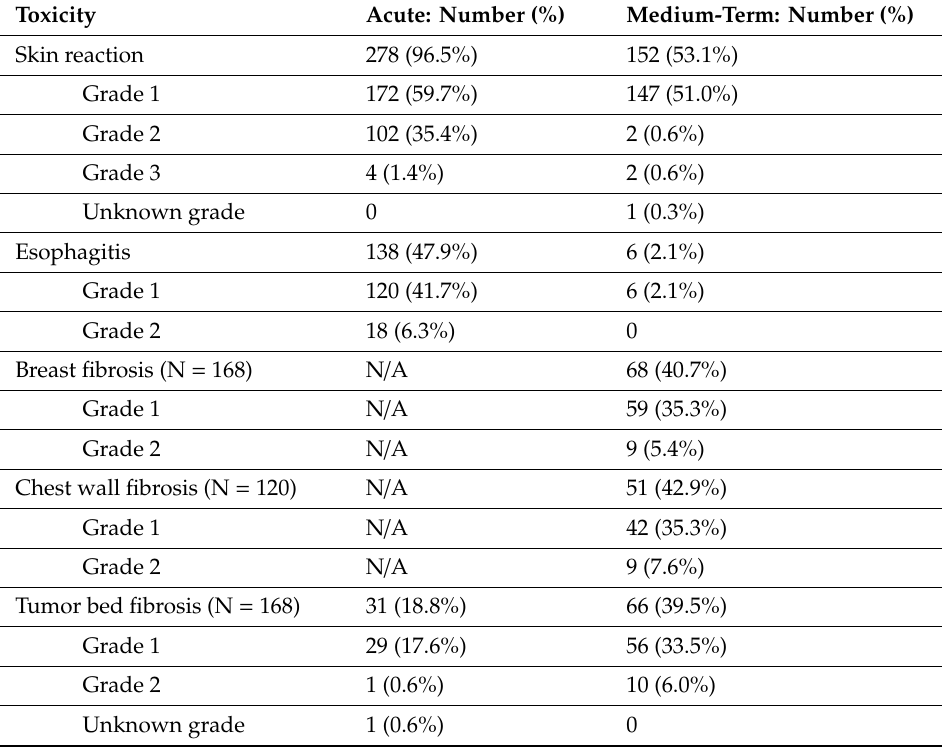
Table 4. Acute and medium-term